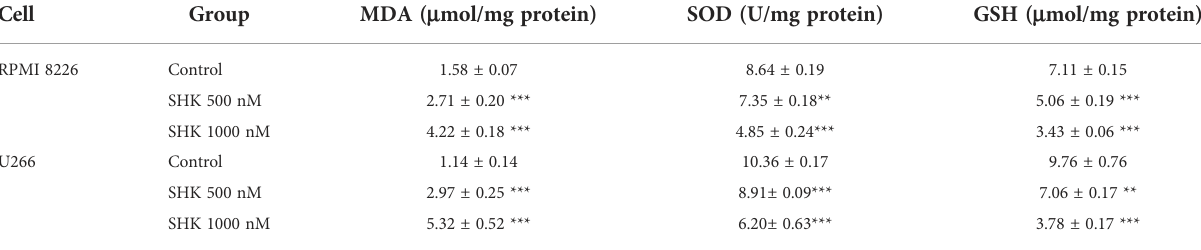
TABLE 2 Effects of SHK on MDA, SOD and GSH levels in MM cells.